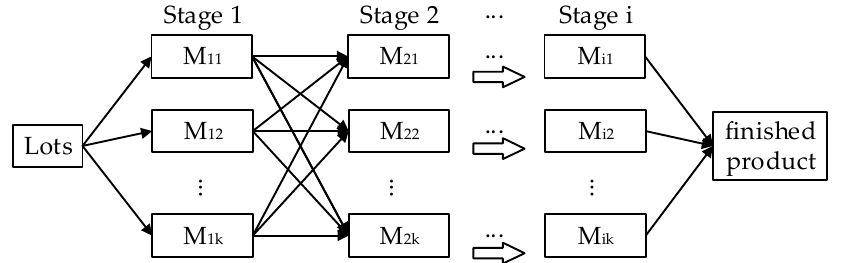
Figure 2. Framework of the hybrid flow shop environment.